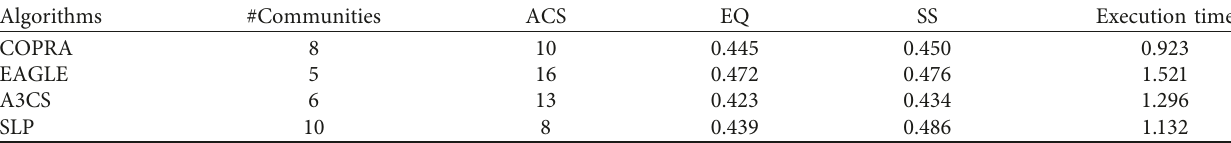
Table 1: The comparison of the four community detection algorithms on Haggle.